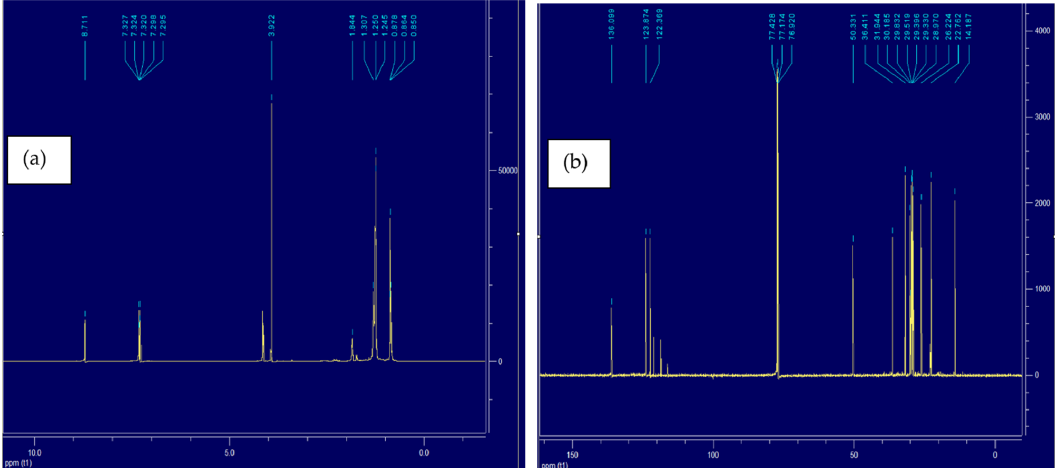
Figure 8. ( a ) 1 H NMR spectra of pure IL4, ( b ) 13 C NMR spectra of pure IL4.